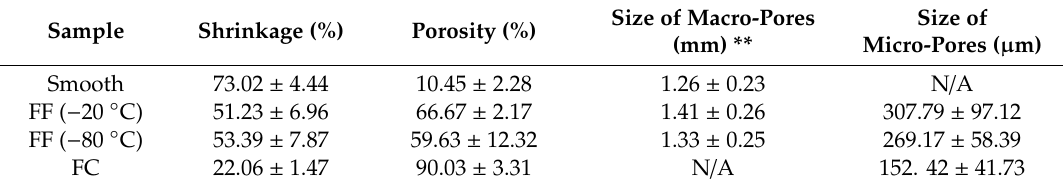
Table 1. Shrinkage, porosity*, and average pore size of sca ff